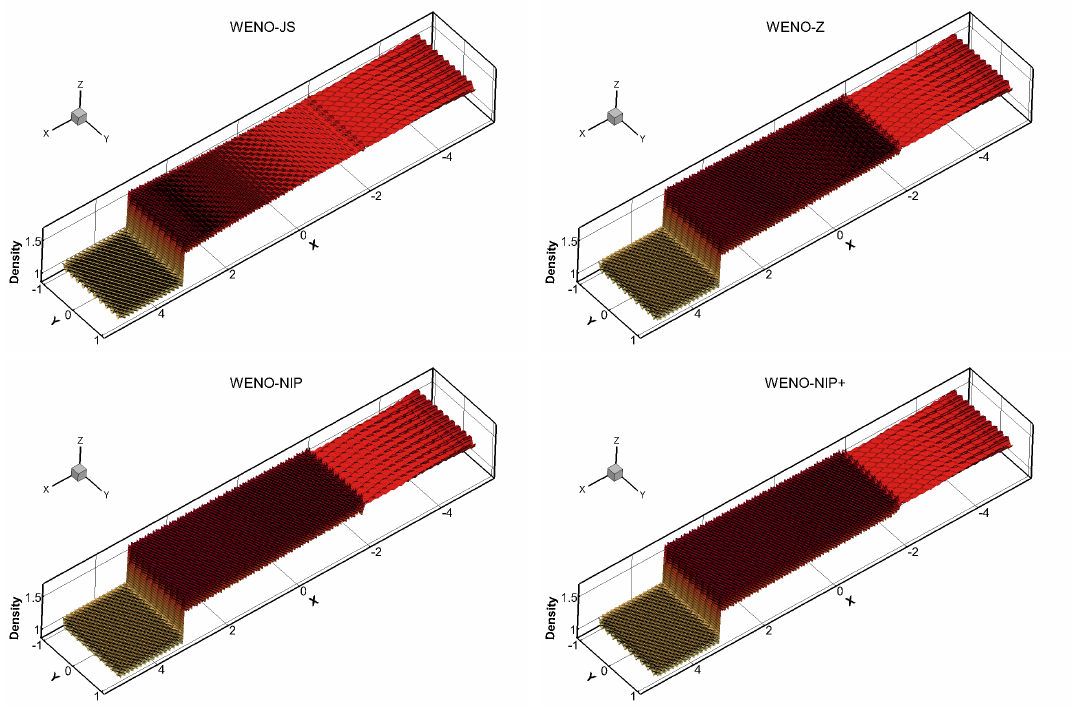
Figure 20. Numerical solutions of the 2D shock-density wave interaction of Titarev and Toro using 1500 × 300 cells at t = 5.0. Left upper corner, WENO-JS. Right upper corner, WENO-Z. Left lower corner, WENO-NIP. Right lower corner, WENO-NIP+.